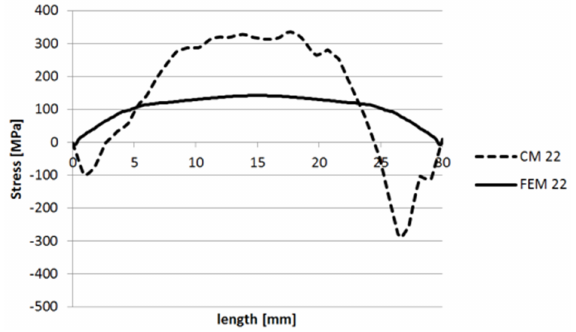
Figure 56. Stress levels in 22 direction along the CD line segment.